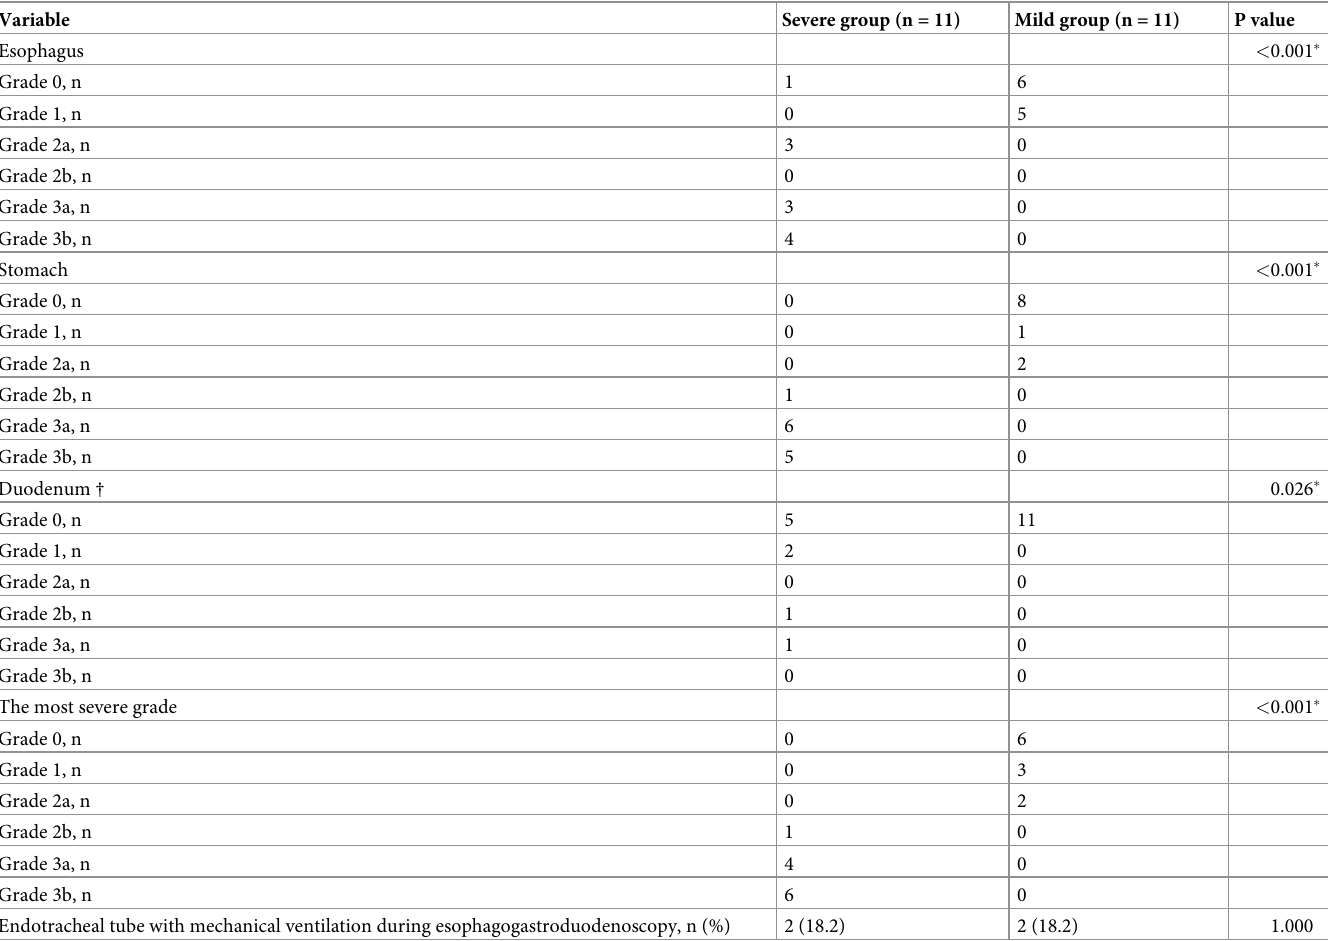
Table 1. Esophagogastroduodenoscopy findings of patients with caustic gastrointestinal injury (n =